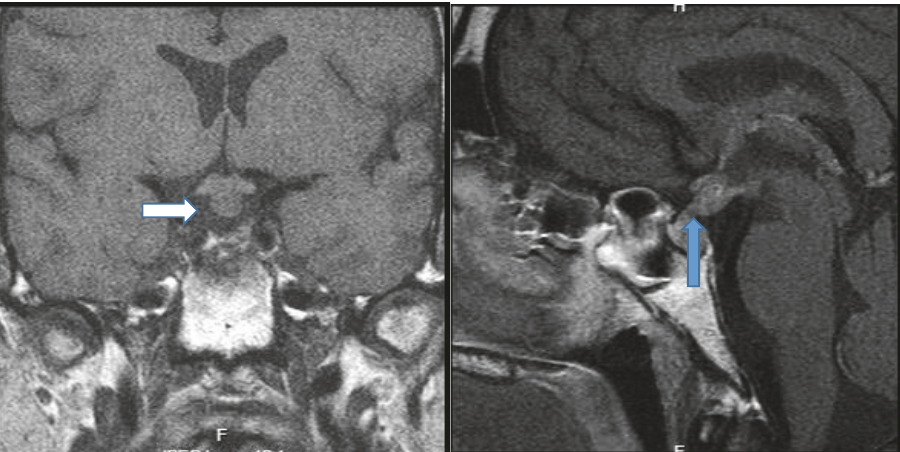
Figure 1: Magnetic resonance imaging (MRI) with gadolinium. A: T1-weighted showing diffuse thickening of the infundibulum (white arrow). B: T1-weighted sagittal showing absence of the posterior pituitary bright spot (blue arrow).